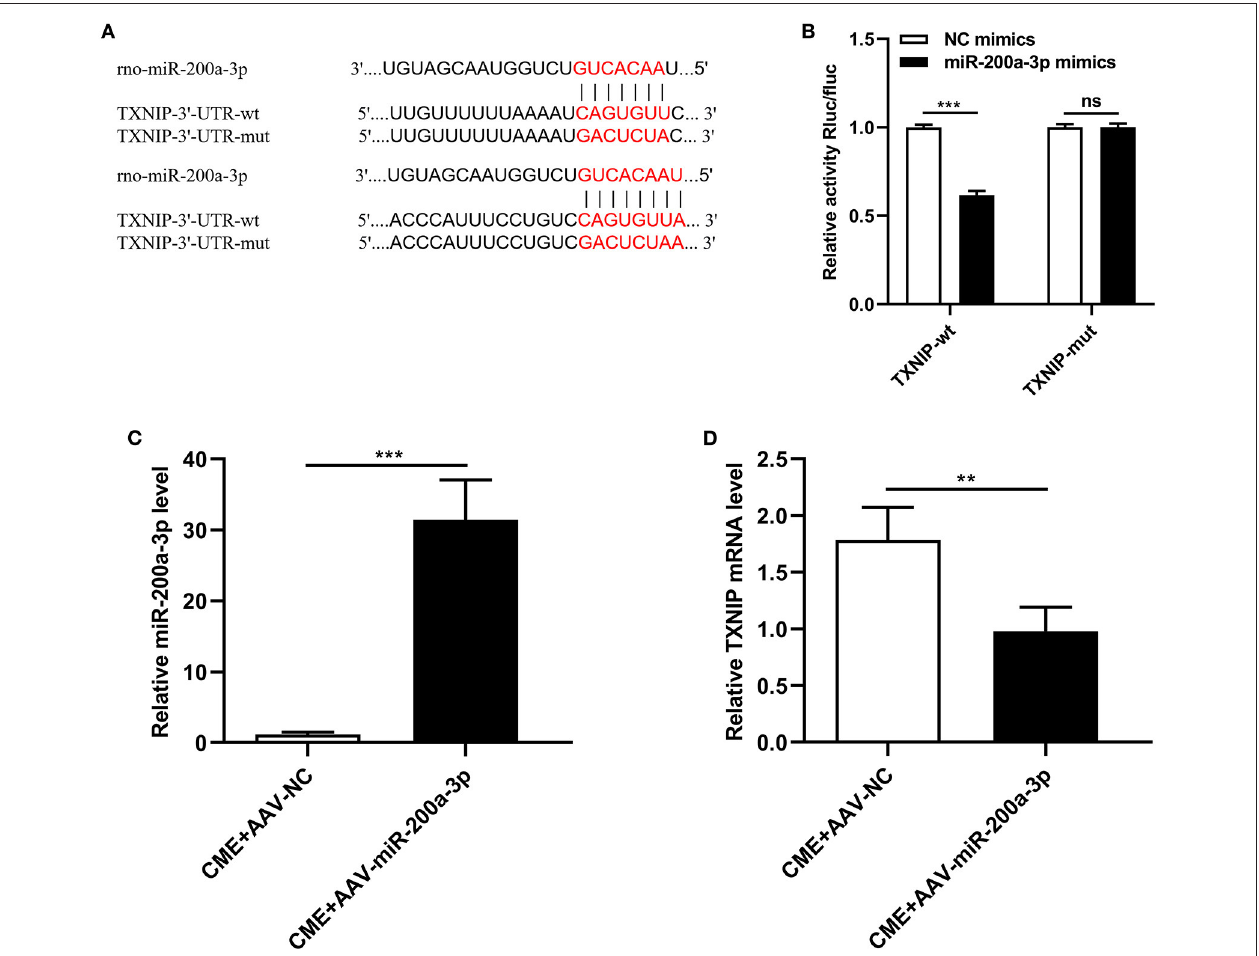
FIGURE 3 | miR-200a-3p directly suppresses TXNIP expression. (A) Schematic of complementary miR-200a-3p and TXNIP 3 ′ -UTR sequences. (B) HEK-293T cells were co-transfected with wild-type or mutant TXNIP 3 ′ -UTR reporter constructs and miR-200a-3p mimics or corresponding negative controls. (C) qRT-PCR was used to assess myocardial miR-200a-3p levels ( n = 4 per group). (D) qRT-PCR was used to assess myocardial TXNIP mRNA levels ( n = 5 per group). The data are presented as the mean ± standard deviation (SD). ** P < 0.01, *** P < 0.001, ns, not significant. CME, coronary microembolization. wt, wild-type; mut, mutant; UTR, untranslated